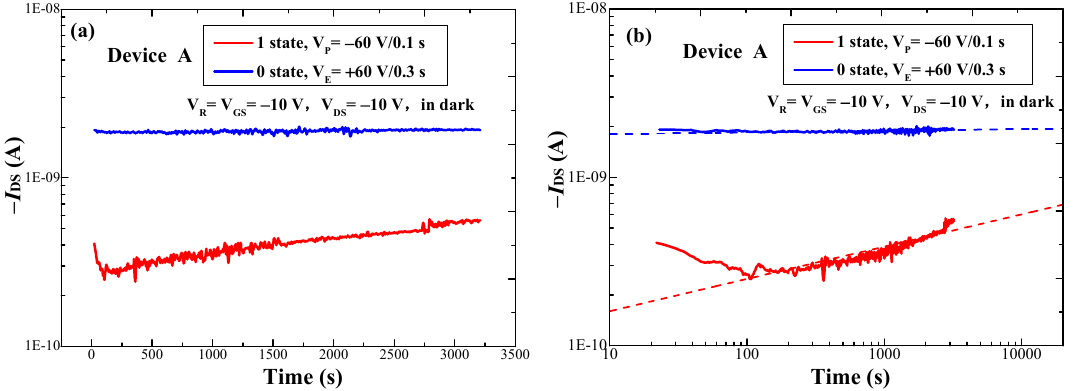
Figure 7. Retention characteristics of device A ( a ) in linear and ( b ) exponential time coordinate.